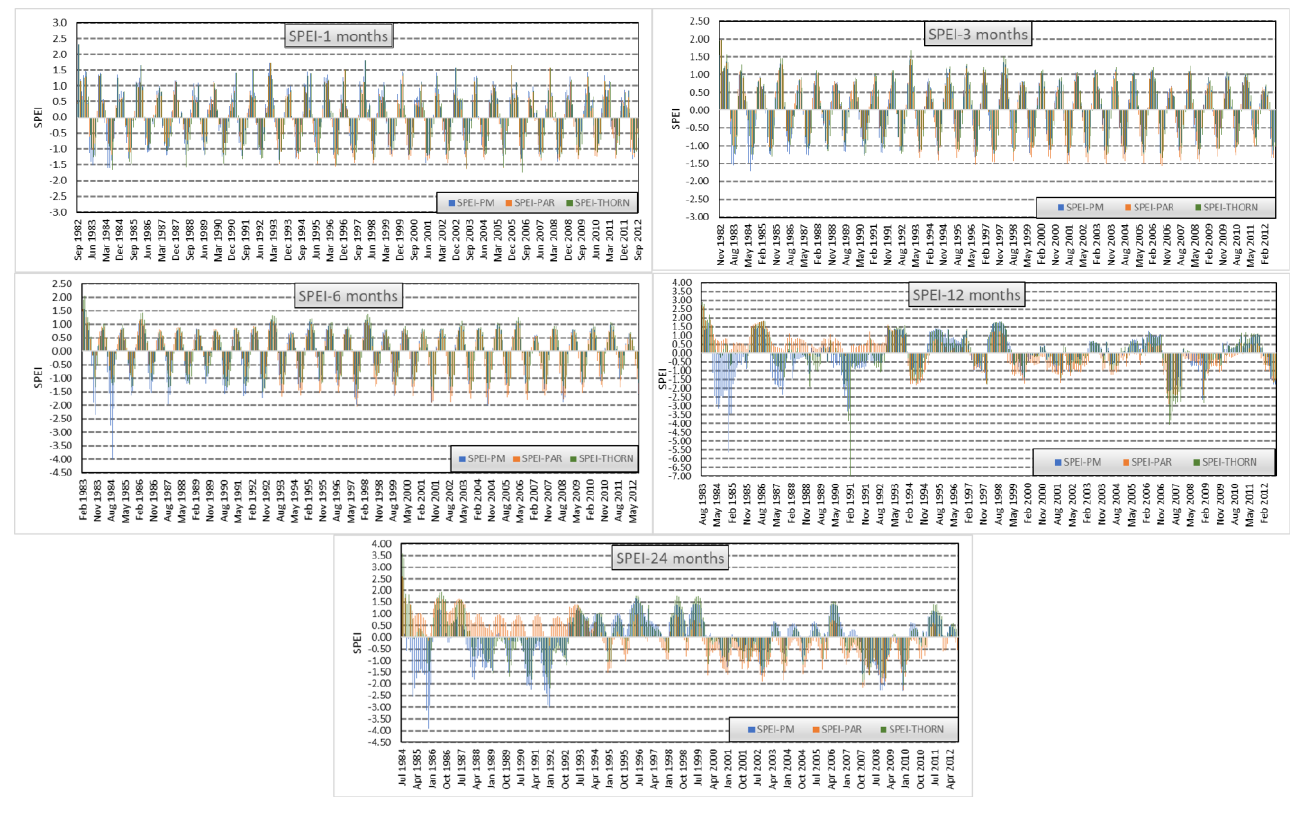
Figure 2. SPEI Davis meteorological station.